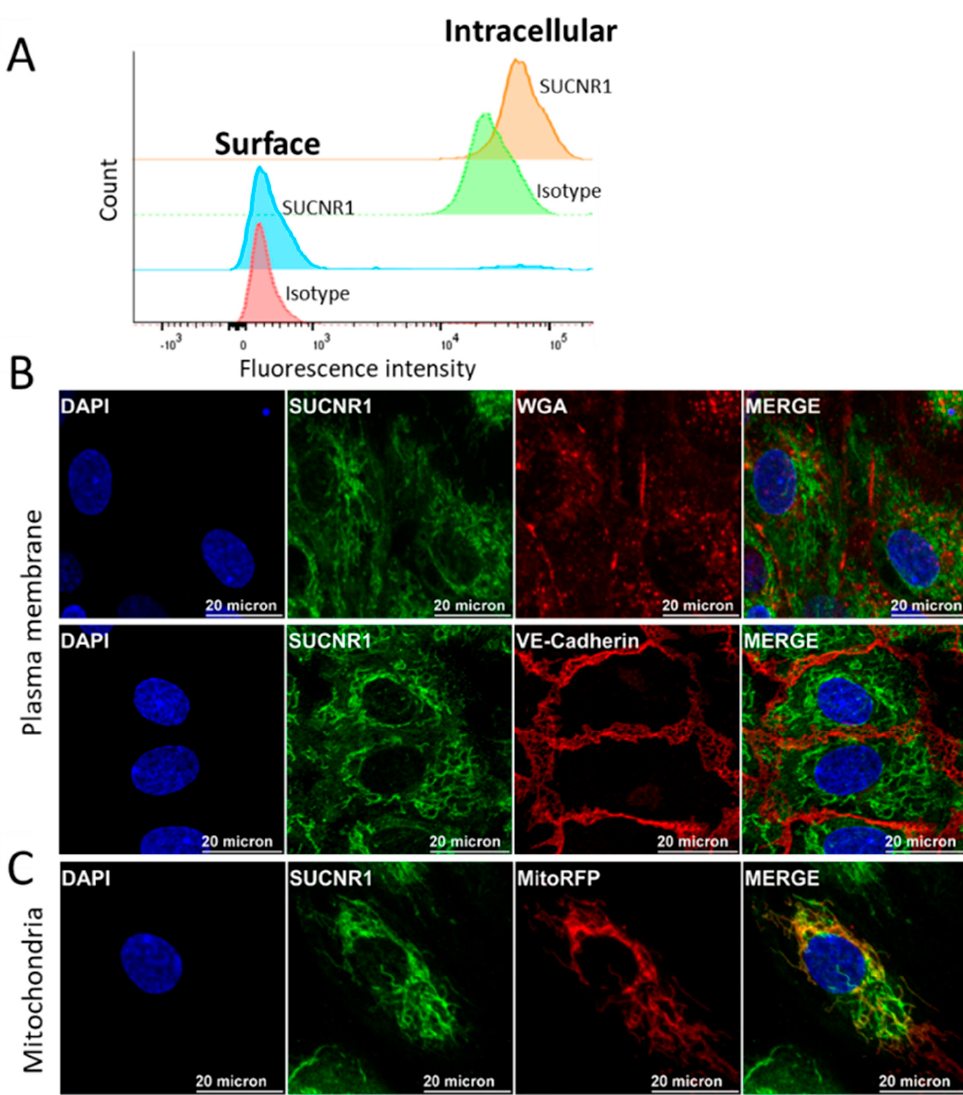
Figure 3. Surface and intracellular expression of SUCNR1 in HUVECs . ( A ) Flow cytometry staining of SUCNR1 in HUVECs with or without prior permeabilization steps ( n = 3). ( B ) Immunofluorescence staining of SUCNR1 in non-permeabilized HUVECs labeled with plasma membrane markers (WGA: apical, and VE-Cadherin: basolateral sides) and DAPI. ( C ) Immunofluorescence staining of permeabilized HUVECs, using mitochondrial RFP, antibody against SUCNR1 and DAPI. For ( B , C ), images are representative for 5 different experiments ( n = 5).